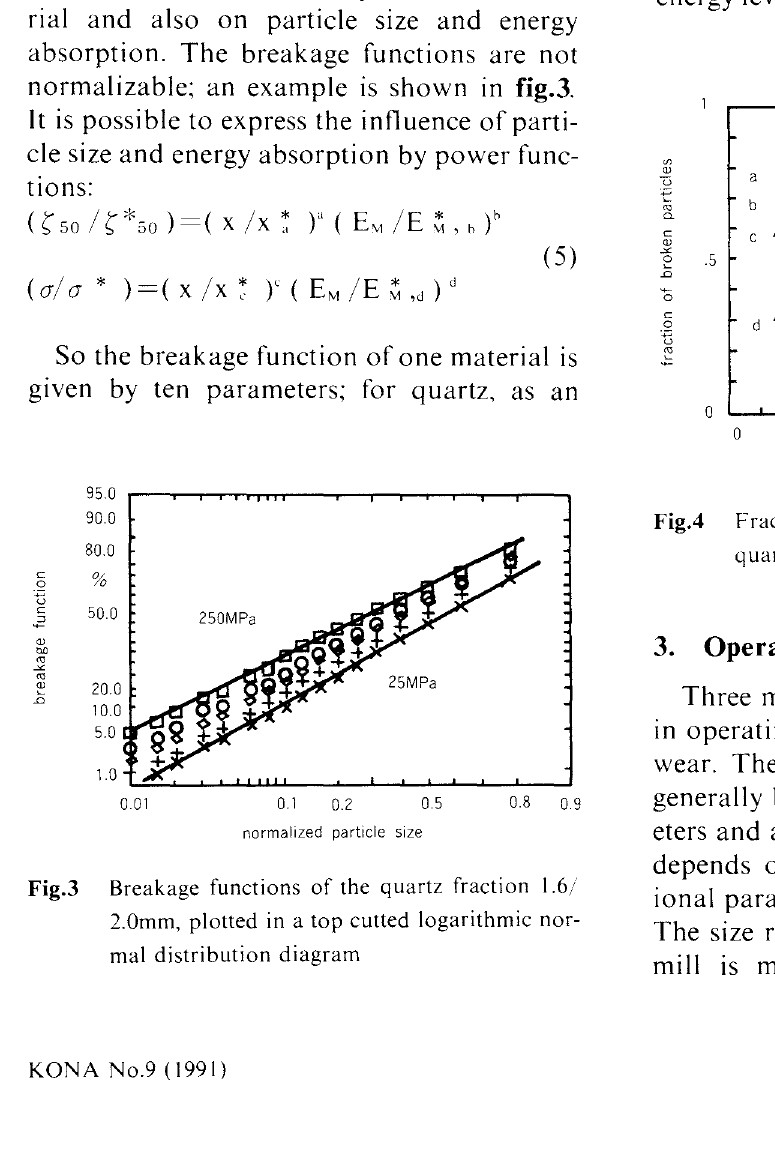
Fig.3 Breakage functions of the quartz fraction 1.6/ 2.0mm, plotted in a top cutted logarithmic nor mal distribution diagram